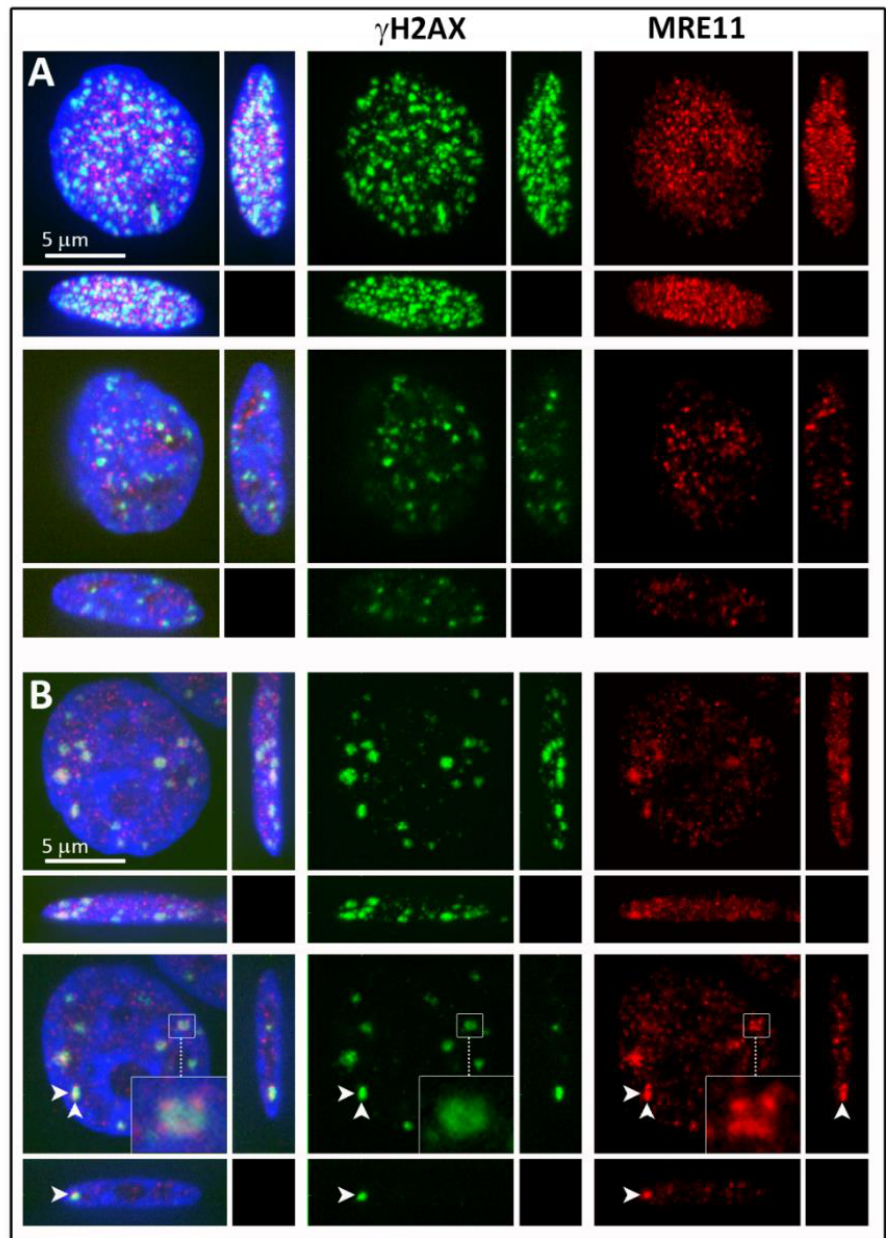
Figure 2. Confocal images of γ H2AX (green) and MRE11 (red) focus formation in breast cancer cells exposed to 2 Gy of γ -radiation and left repair DSBs for 30 min ( A ) or 4 h ( B ). The top line of both panels represents the maximum immunofluorescence confocal microscopy images composed of 40 optical confocal slices (0.2 µ m thick) and shown in all three x-y, x-z, and y-z planes. The bottom lines show a single confocal slice through the nuclei displayed in the top lines. For the post-irradiation period of 4 h, the inserts show a selected γ H2AX+MRE11 focus in a magnified view. The white arrows indicate the position of x-y and y-z confocal planes. Chromatin counterstaining was performed with DAPI (artificially blue).